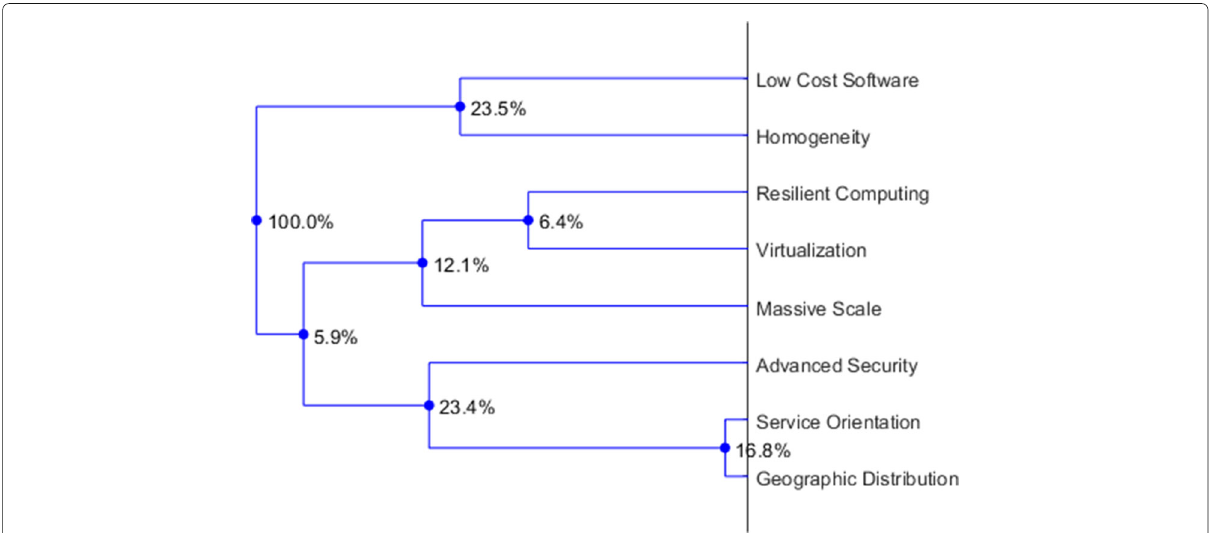
Fig. 10 Hierarchical dendrogram of variables in a 3-dimensional representation of the decomposition of the 8-dimensional partitioned dataset for the common characteristics. Internal nodes are labelled with bootstrap percentages indicating the proportion of times in 1000 bootstrap replicates of the CA analysis that a node is observed. All values are <50%, with a few values much smaller, indicating that this solution is not robust to bootstrap resampling. i.e. no grouping shown here is strongly supported by